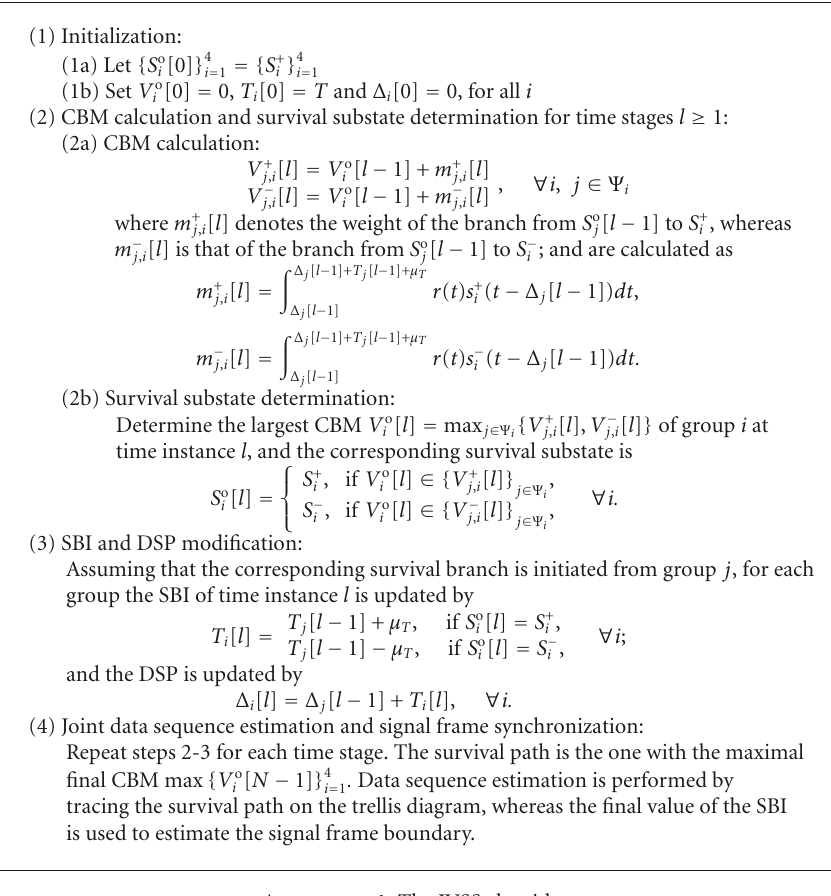
Algorithm 1: The JVSS